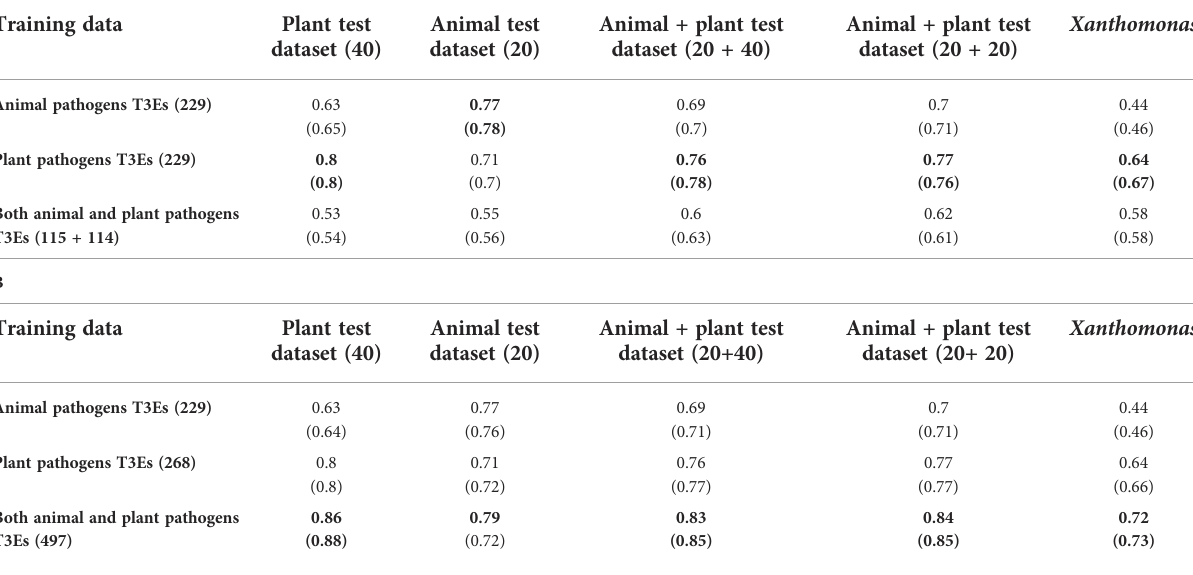
TABLE 4 The performance of the best set of features when applied separately to animal and plant associated bacterial effectors.